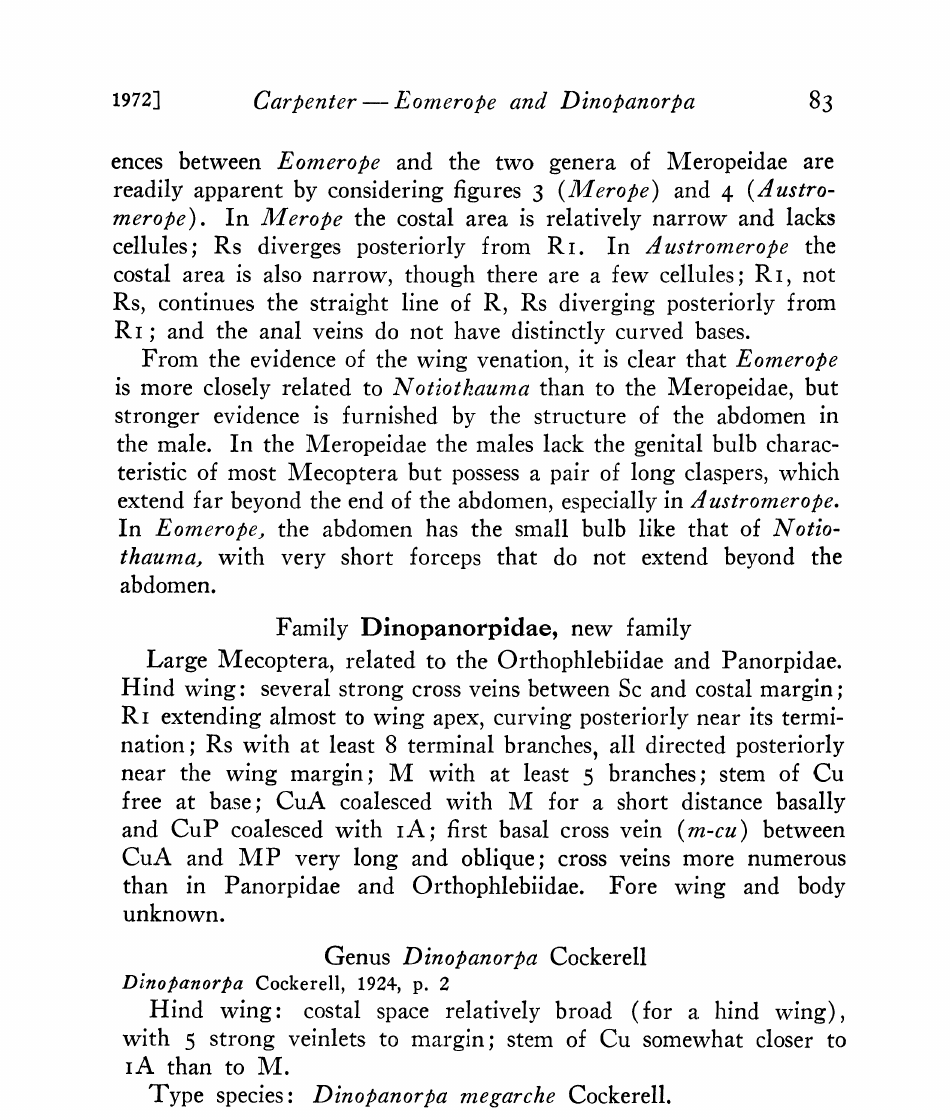
Dinopanorpa megarche Cockerell, 1924, p.